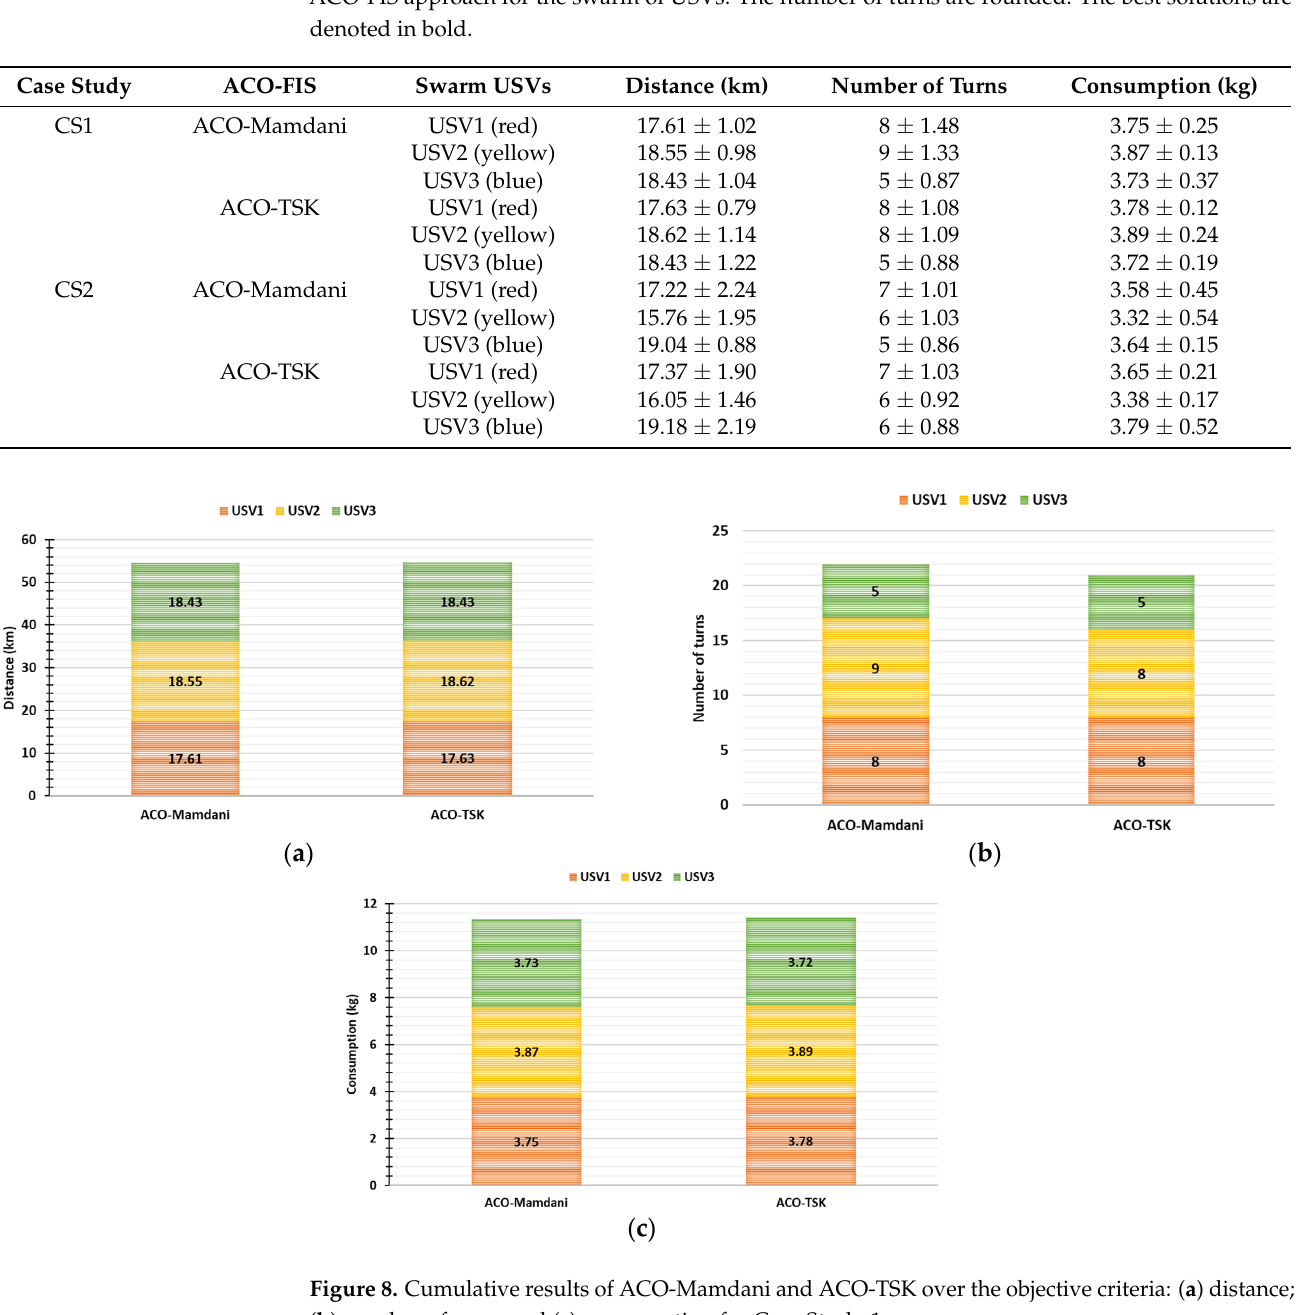
Table 3. Path planning mean results with standard deviation after 20 runs of the case studies for each ACO-FIS approach for the swarm of USVs. The number of turns are rounded. The best solu- tions are denoted in bold.